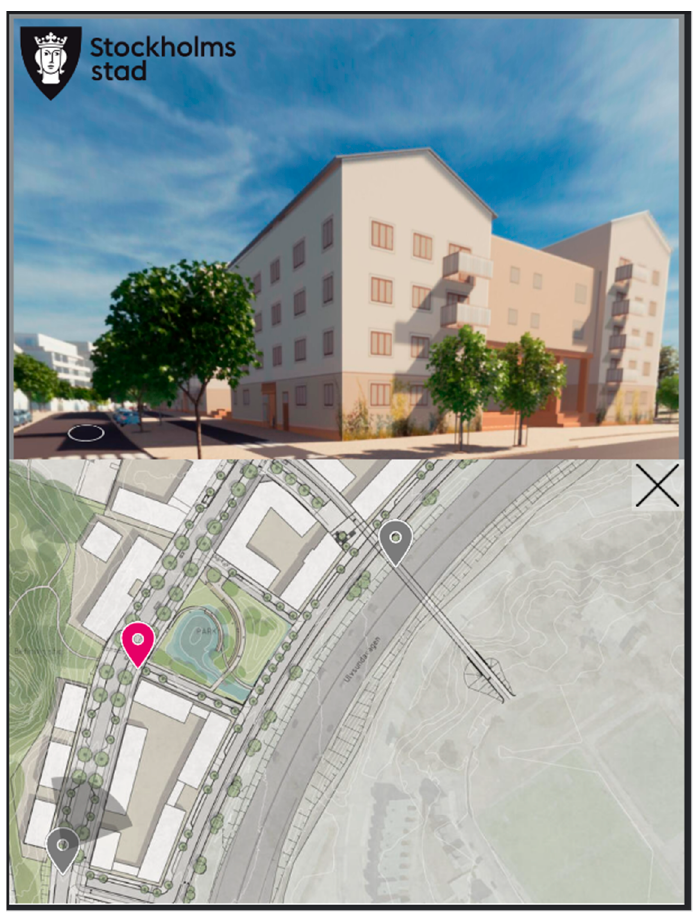
Figure 1. Two 360° images of a proposed building project in the context of the 3D city model in Figure 1. Two 360 ◦ images of a proposed building project in the context of the 3D city model Stockholm. in Stockholm.